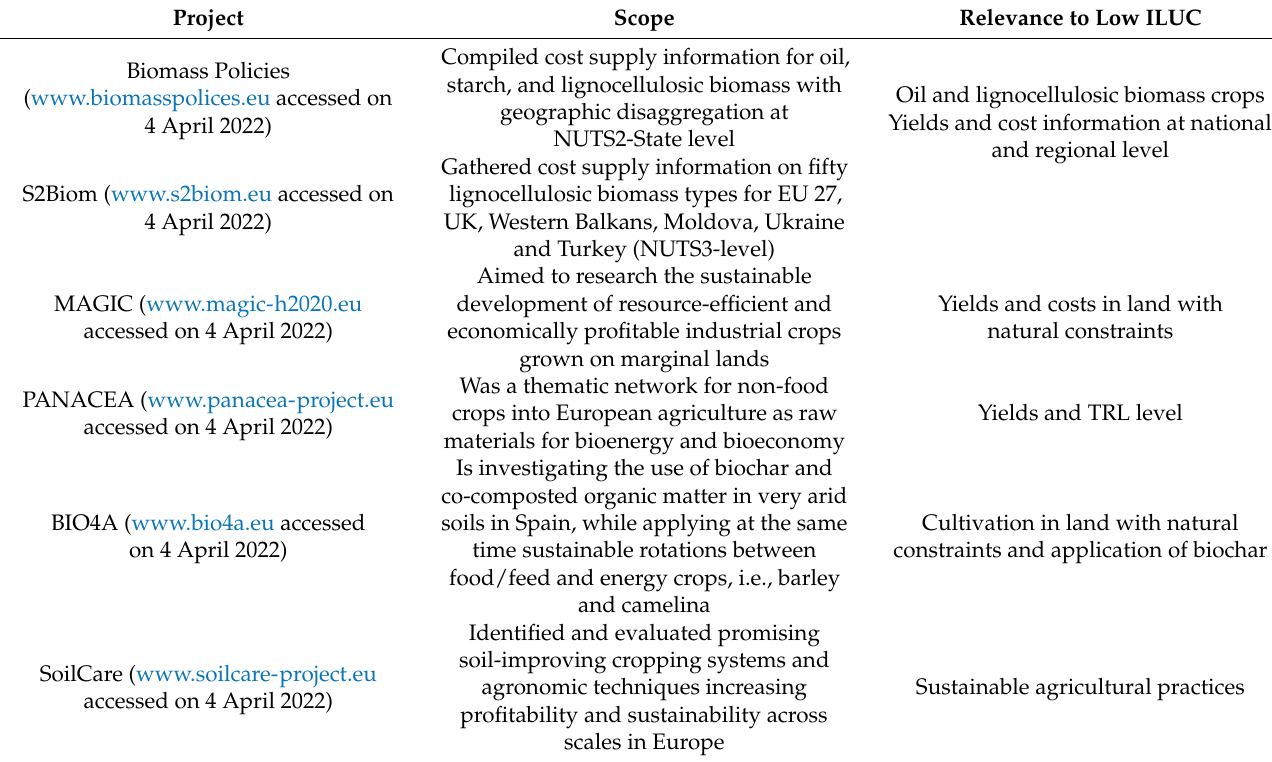
Table 1. European research projects that formed the basis of the